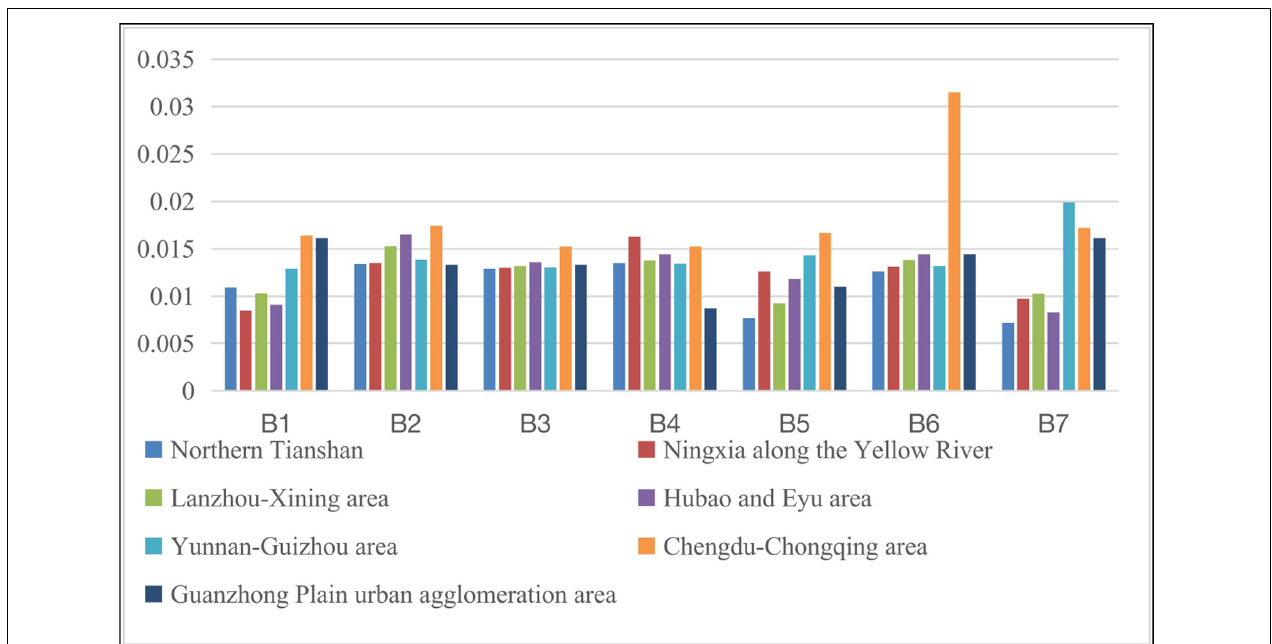
FIGURE 8 | Social development level of each indicator within the western region during 2016–2020.